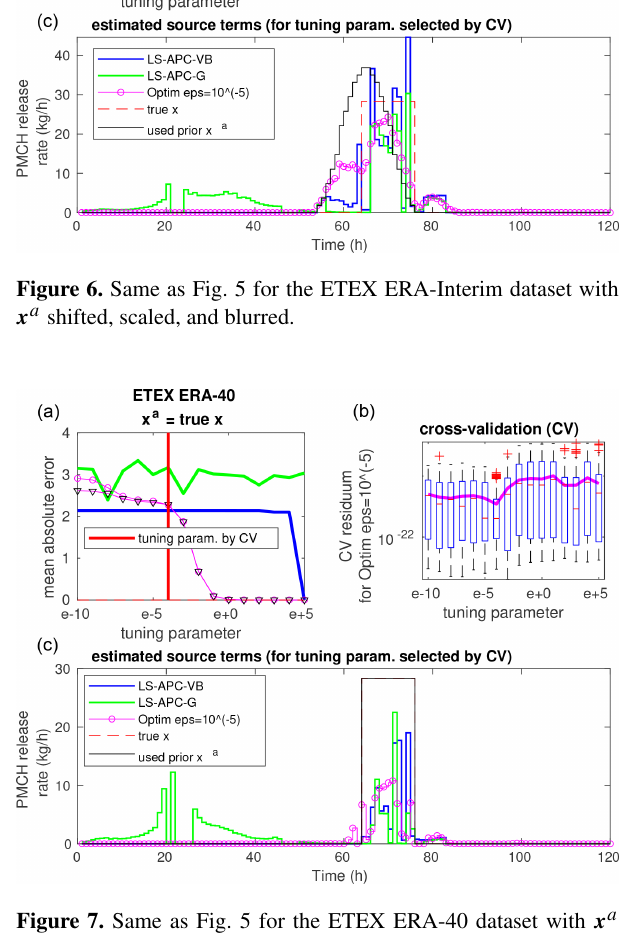
Figure 7. Same as Fig. 5 for the ETEX ERA-40 dataset with x a equal to the true source